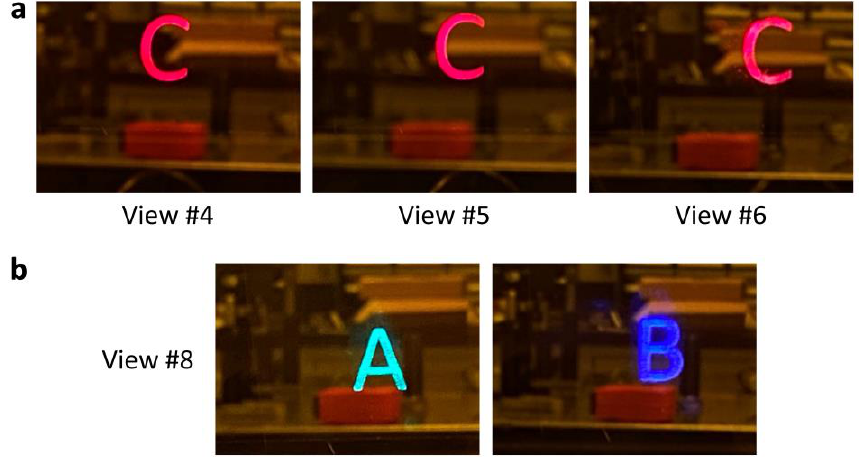
Figure 7. ( a ) Captured images of a red letter, C, at different viewing positions. ( b ) Captured im- ages of a green letter, A, and a blue letter, B, at viewpoint #8. of a green letter, A, and a blue letter, B, at viewpoint